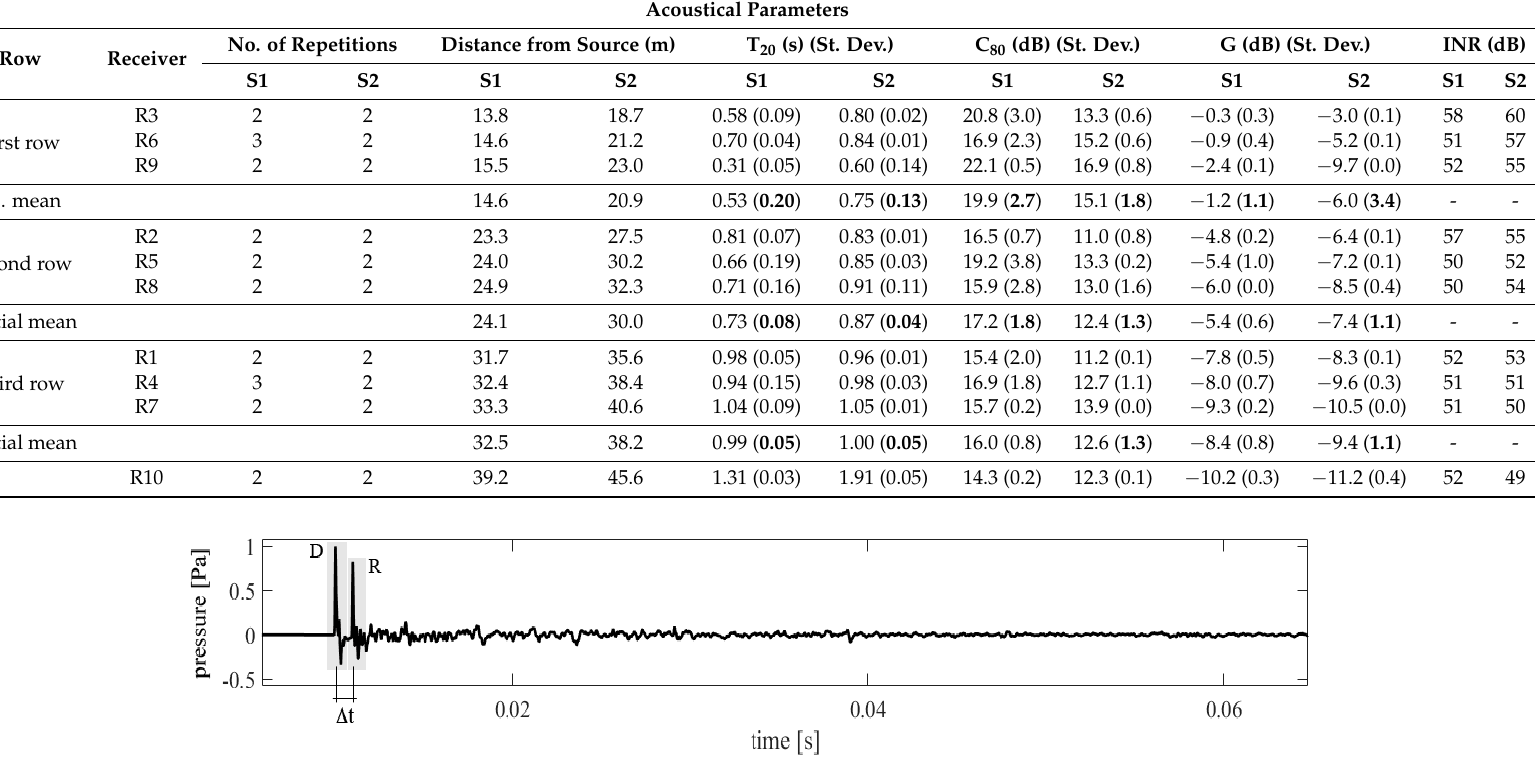
Figure 2. Measured Impulse Response (IR) in Syracusae (SR) for the S1-R6 measurement path, for the firecracker source. Δ t is the time interval between the direct sound (D) and the first reflection (R) from the orchestra floor.